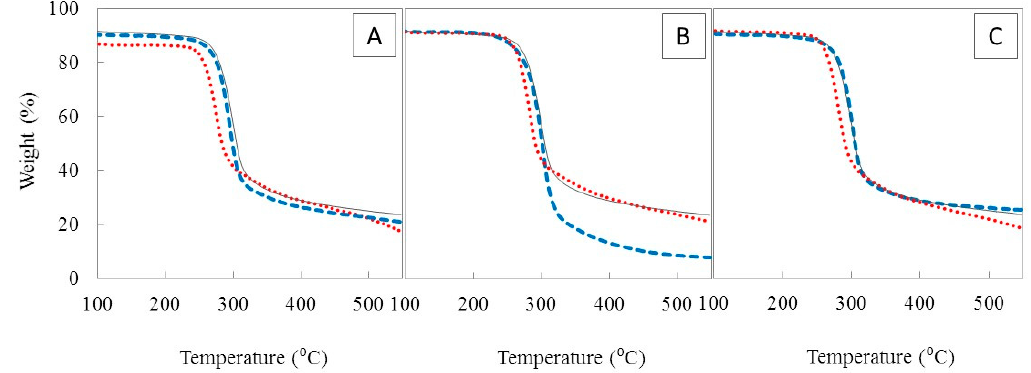
Figure 6. Thermogravimetric analysis (TGA) of the polymers: CGC1 ( A ), CGC2 ( B ) and CGC3 ( C ). Continuous line represents CGC 0 ; Dotted and dashed lines corresponds to first and second soluble fractions, respectively.